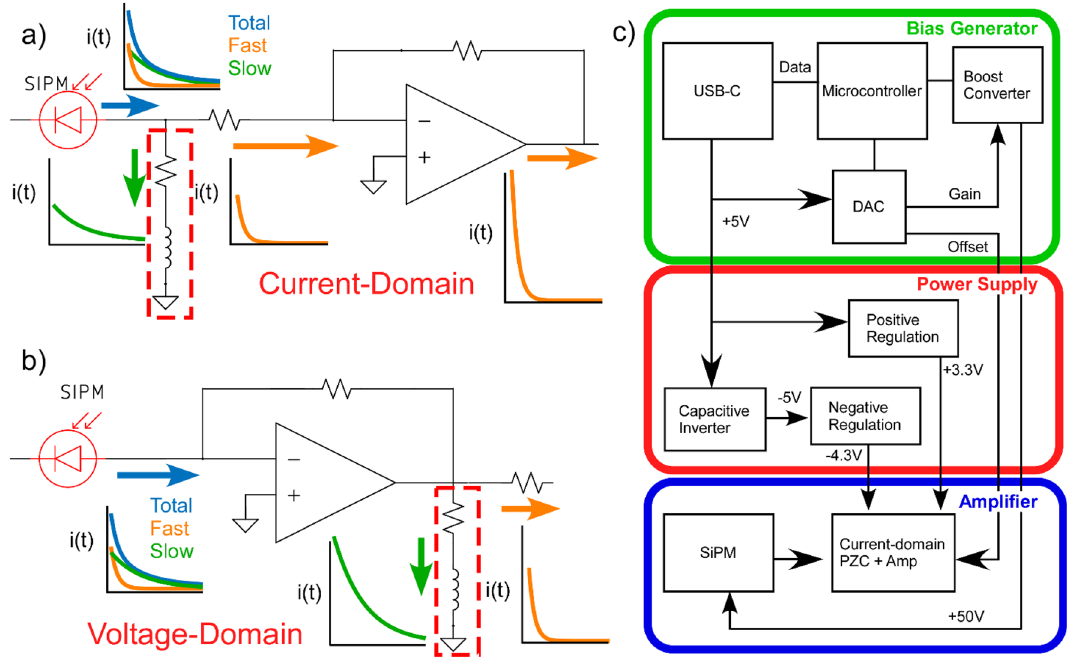
Figure 1. Pole zero cancellation schematics. ( a ) Proposed current-domain pole zero cancellation. The SiPM generates a multiexponential signal containing a small fast component, and a ten-fold larger slow component. A current divider with a series inductor (boxed component) shunts the larger slow component to ground while passing the fast component to the amplifier. ( b ) Conventional voltage-domain transimpedance amplifier. The entire multiexponential signal is amplified, and then after amplification the amplified slow component is removed by the inductor, wasting most of the amplifier dynamic range. ( c ) Block diagram of the current-domain PZC with bias generator and power supply.